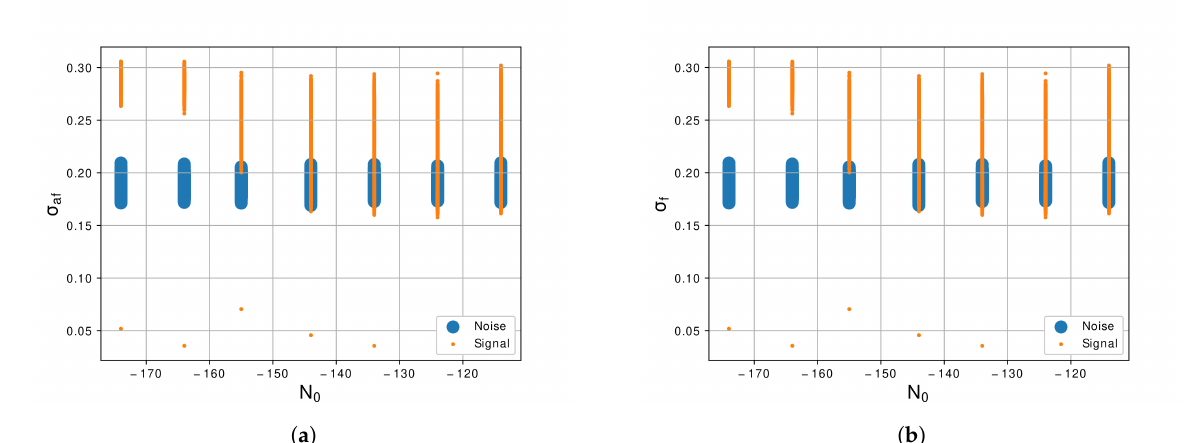
Figure 6. Graphic of the features ( a ) σ af , Equation (7), and ( b ) σ f , Equation (8), with the variation of N 0 of − 114 dBm/Hz to − 174 dBm/Hz.